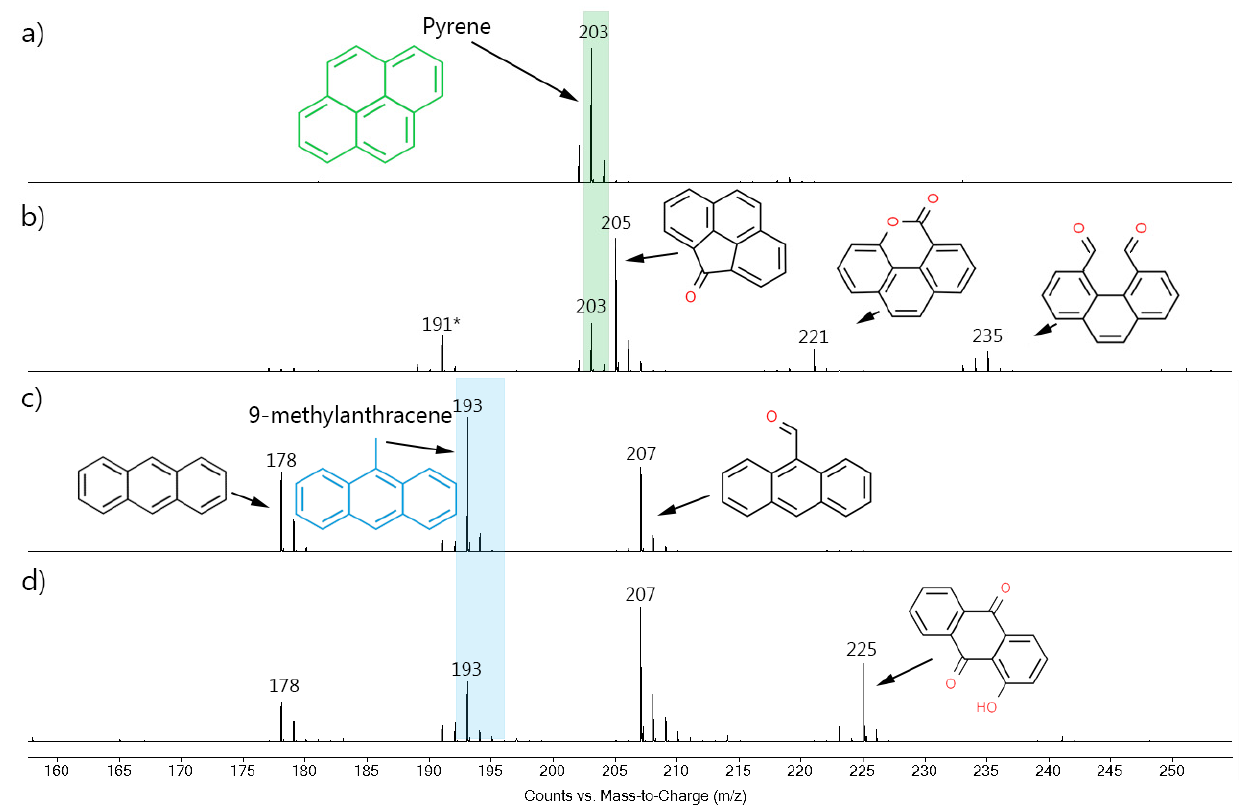
Figure 3. MS spectra of the ( a ) untreated and ( b ) treated pyrene; and of the ( c ) untreated and ( d ) treated 9-methylanthracene, both in the homogeneous ozonolysis experiments performed using acetonitrile as solvent. Green and blue rectangles indicate pyrene and 9-methylanthracene signals, respectively. * indicates unidentified structure.